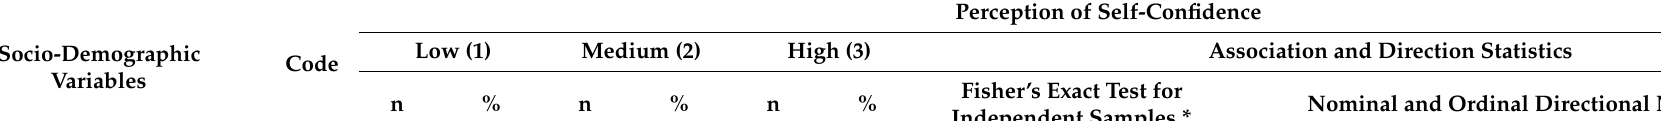
Table 1. Study Variables, Associations and Direction Statistics. If we add this last column, we would present the table